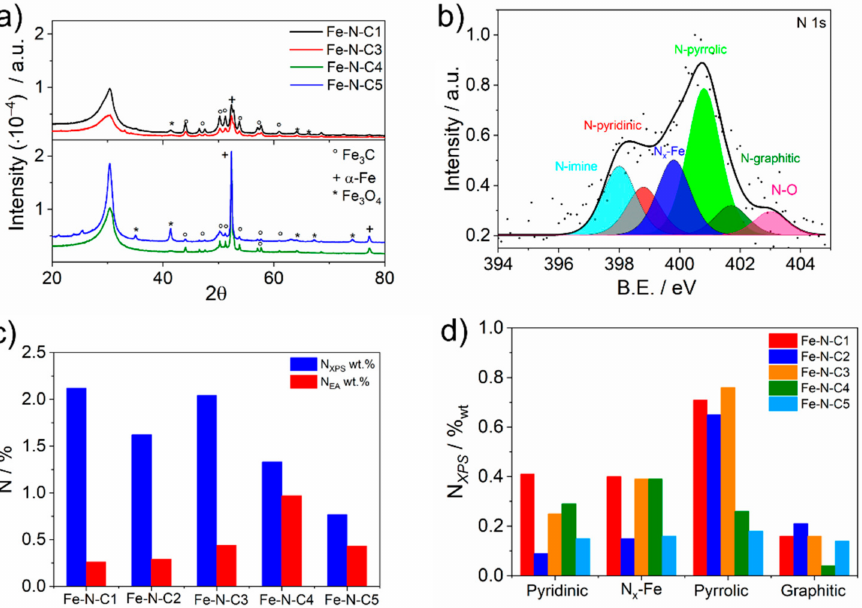
Figure 4. ( a ) XRD spectra acquired before acid wash in H 2 SO 4 ; ( b ) Example of high-resolution core-level XPS spectra of N 1s and deconvolution for Fe-N-C5; ( c ) Superficial and bulk (N EA ) nitrogen content as determined by XPS and elemental analysis, respectively and ( d ) Surface nitrogen speciation in each Fe-N-Cn